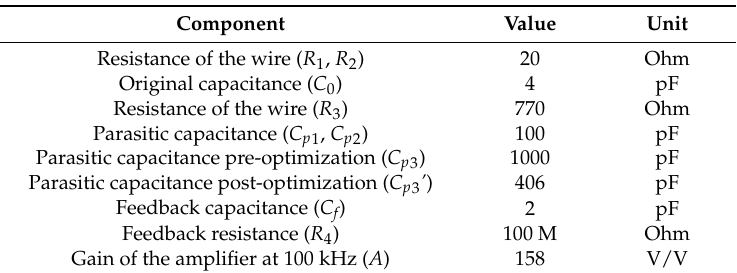
Table 1. Parameters of the